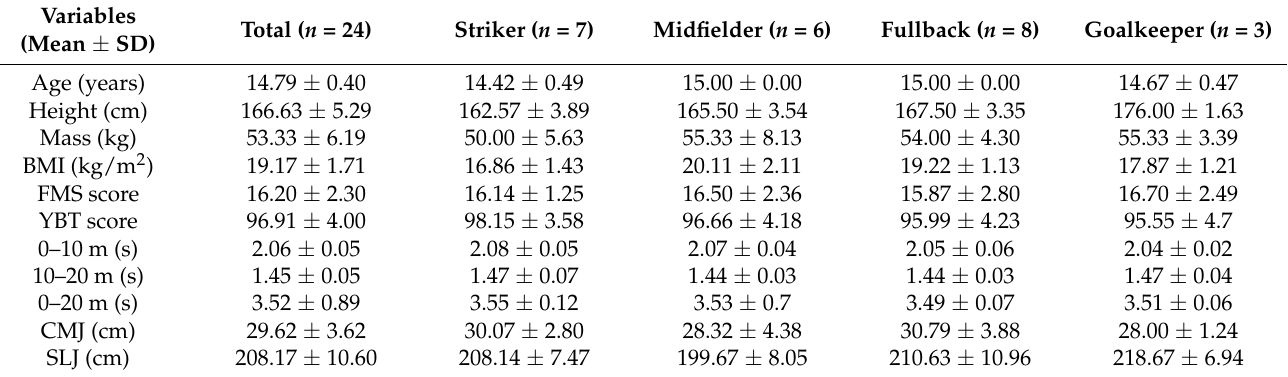
Table 1. Descriptive statistics for characteristics of participants, functional screening, and physical performance.